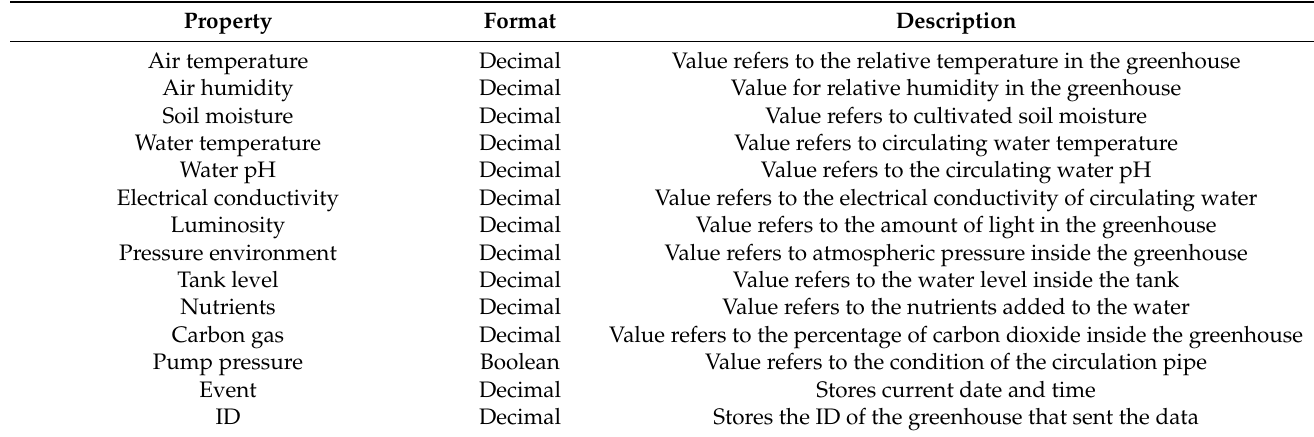
Table 2. Historical contexts of information